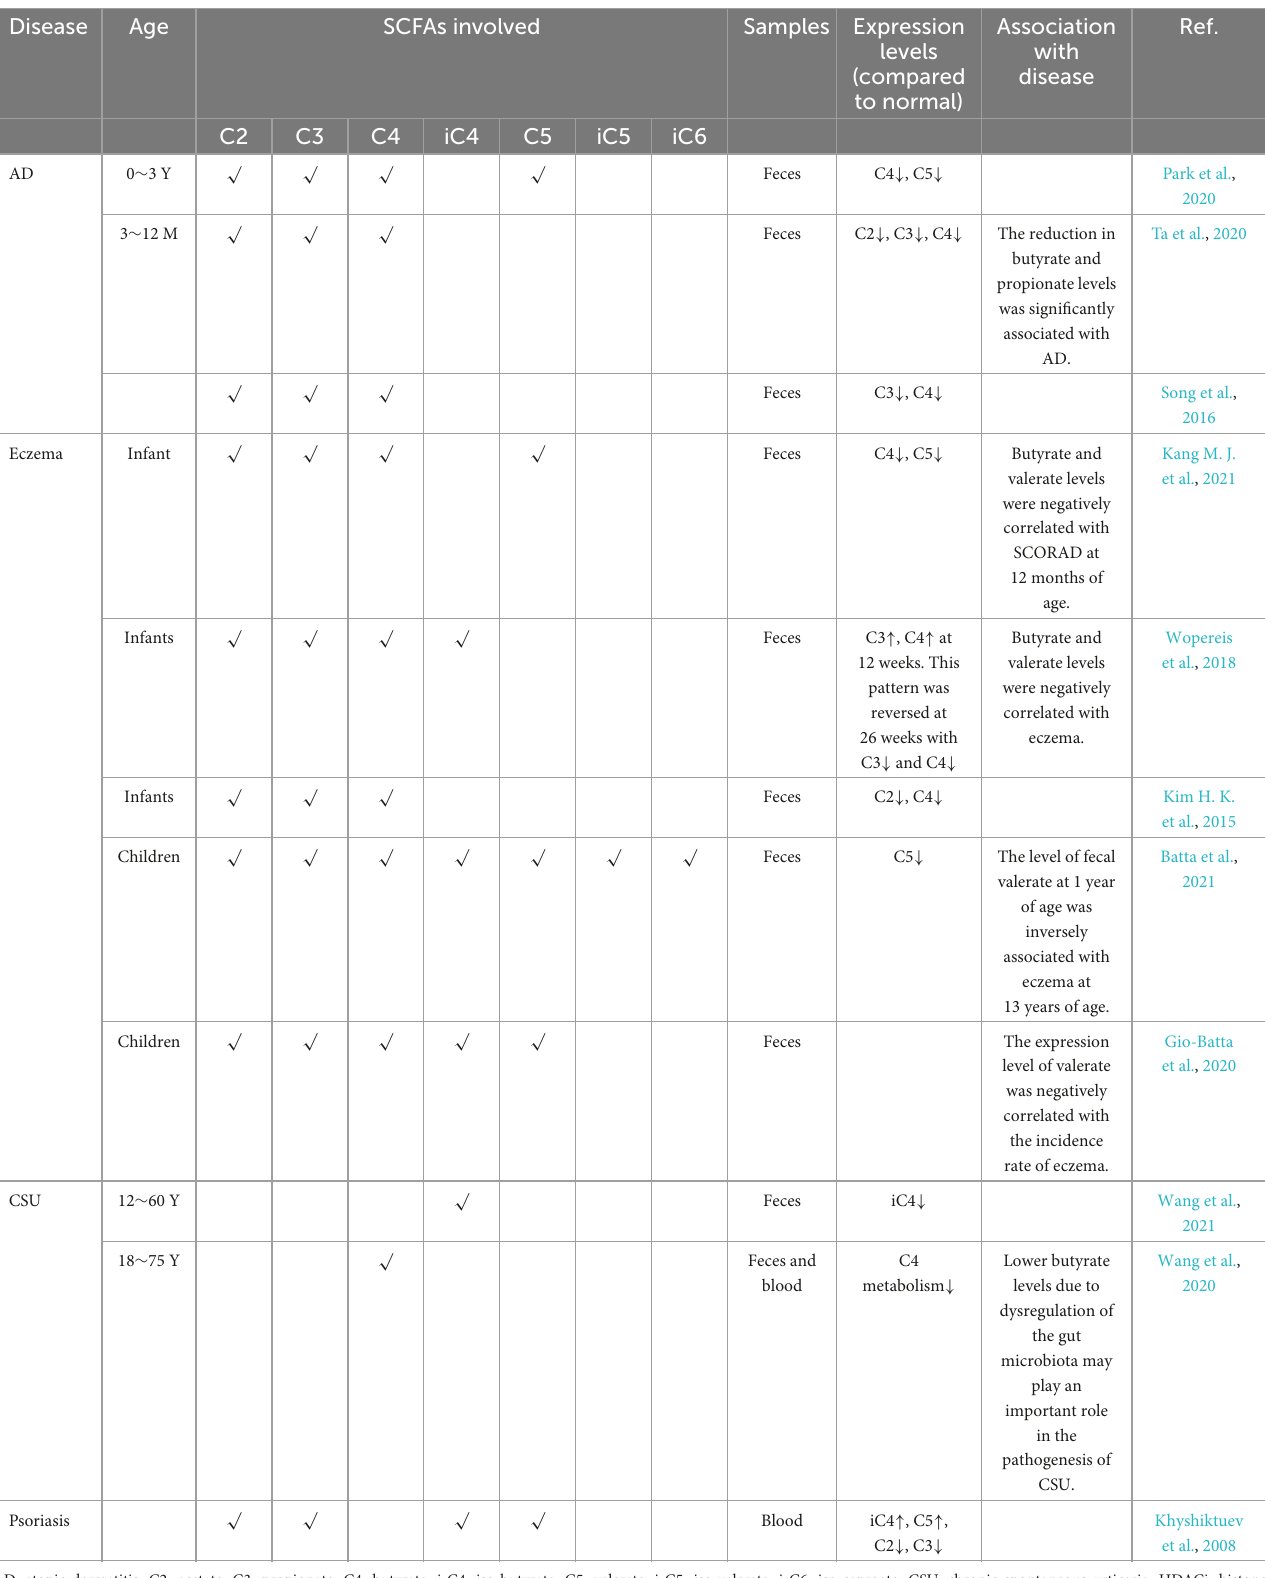
Association levels with (compared disease